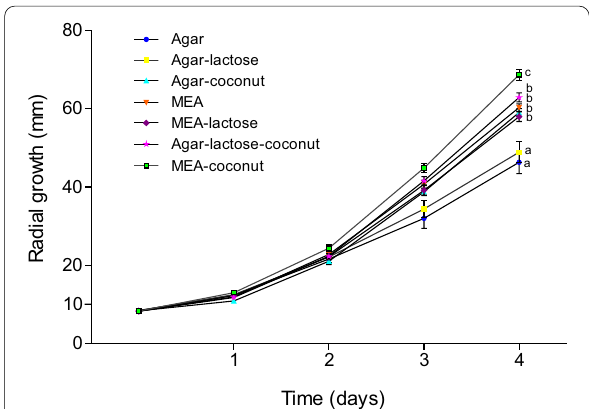
Fig. 1 Mean radial growth (mm) of M. esculenta (CDBB‑H‑482) and FRE‑3C in different culture media (n